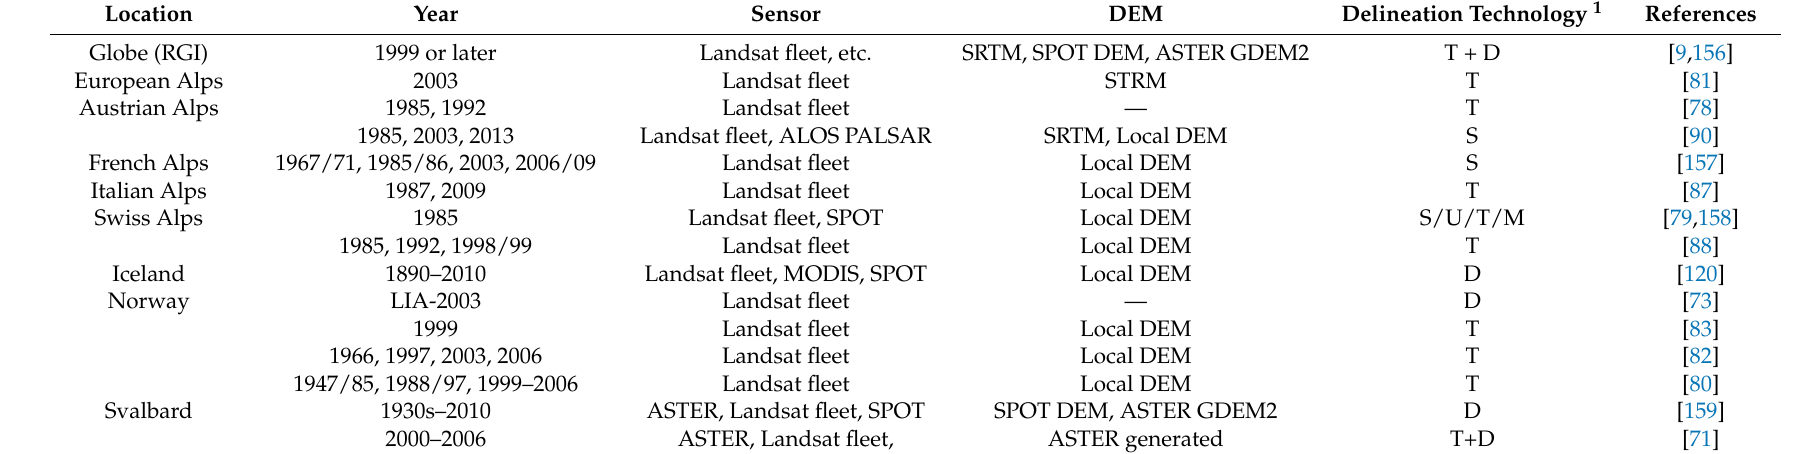
Table 1. References for existing glacier inventories derived from satellite imagery for European glaciers (excluding